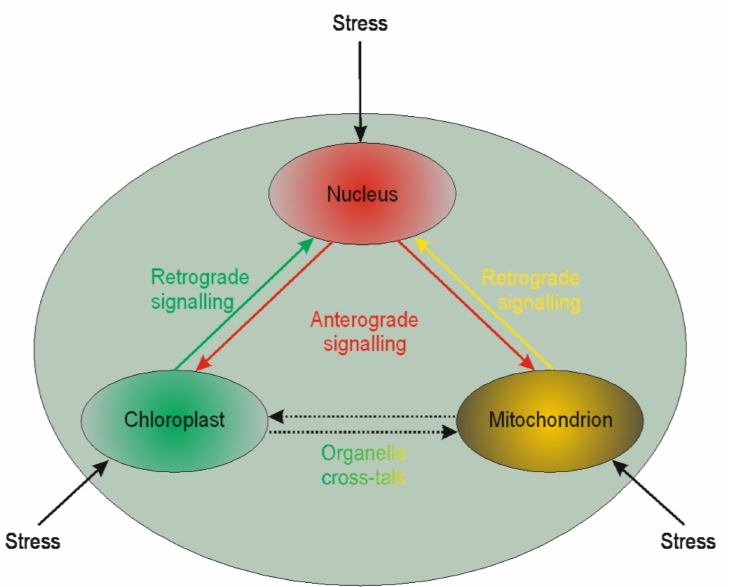
Figure 1. Schematic illustration of interplay between cellular organelles. Anterograde is the signaling from the nucleus towards chloroplasts or mitochondria, whereas the reversed direction is called ret- rograde signaling. The communication between mitochondria and chloroplast (and other organelles except but nucleus) is called